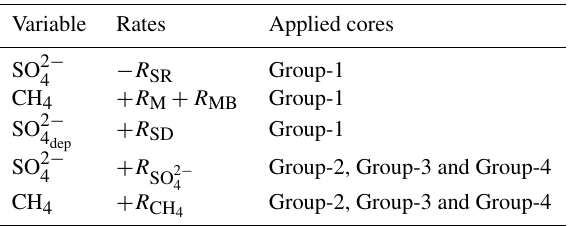
Table A1. Rate expressions applied in the differential equations ( R C in Eq.